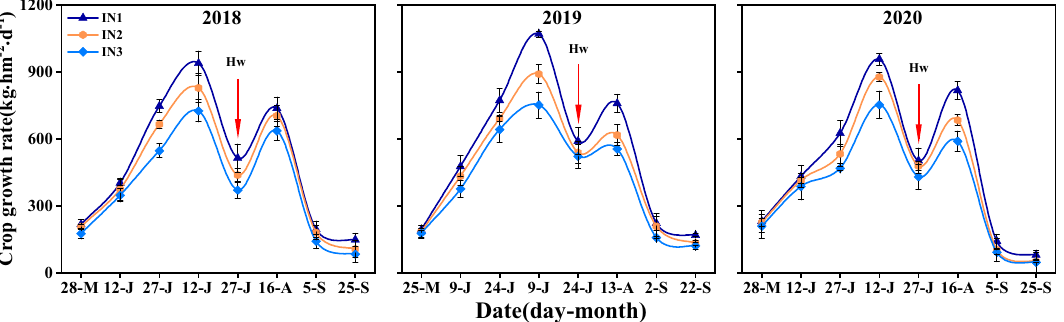
Figure 1. Crop growth rate of intercropping system with different N management practices in 2018–2020. I, intercropping. N 1 , N 2 , and N 3 represent N-fertilizer applied at 51, 72, and 93 kg N ha −1 as first top-dressing plus 63, 42, and 21 kg N ha −1 at third top-dressing, respectively. Plant sampling time is 15 day intervals before wheat harvest and 20 day intervals after wheat harvest. Error bars indicates standard error of the means ( n = 3). Arrows labeled Hw indicates wheat harvest